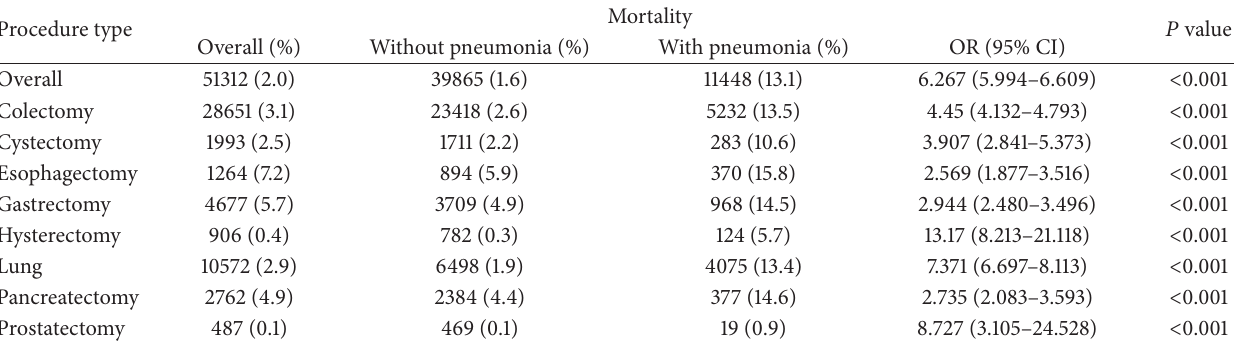
Table 3: Multivariable logistic regression analysis after fitting with generalized estimating equation (GEE) and covariables (age, gender, race, CCI, insurance status, median household income by ZIP code, annual hospital volume, hospital location, hospital region, and